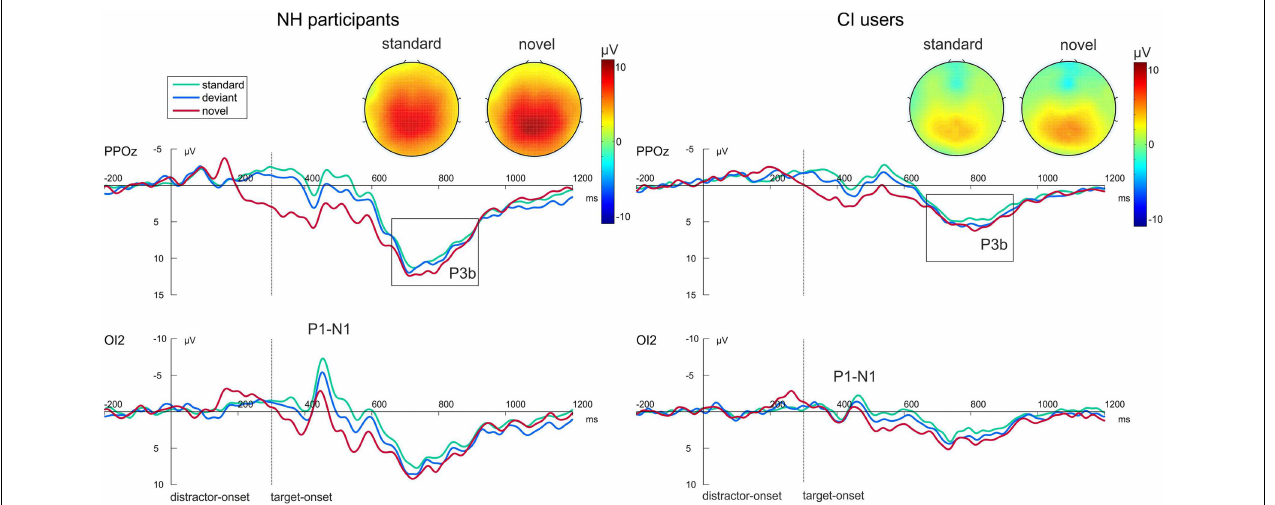
FIGURE 5 | Grand average ERP data for NH participants (left) and CI users (right) in the auditory-visual DFD at PPOz and IO2. Standard trials are marked in green, deviant trials in blue and novel trials in red. Onset of the visual task-relevant stimulus is at 300ms.